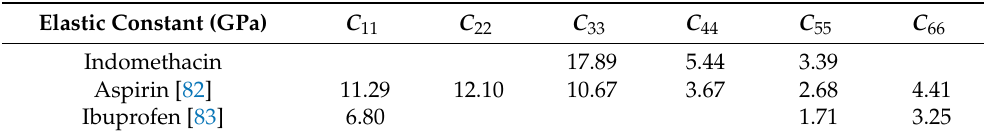
Table 2. Elastic constants, c ij , of the γ -form IMC crystal at 296 K. Those of similar drug materials, aspirin, ibuprofen, are also shown for comparison